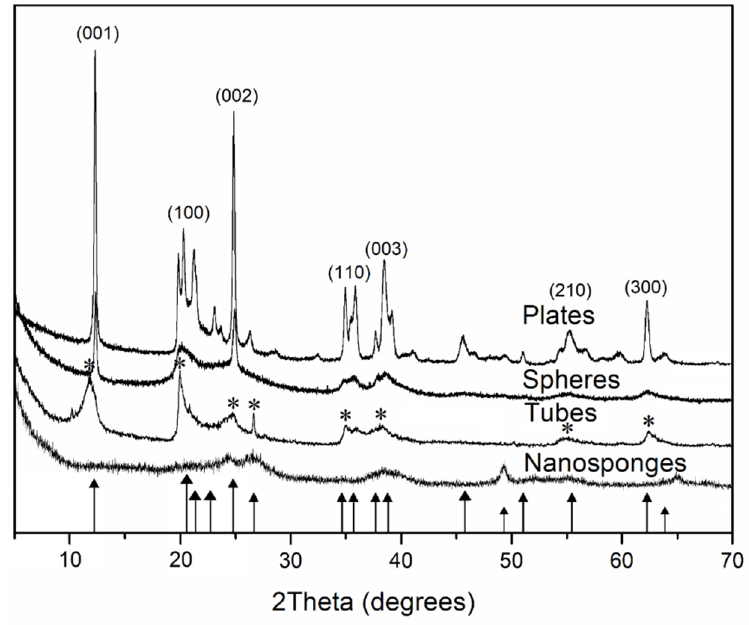
Figure 1. X-ray diffraction patterns of the synthetic aluminosilicate with different morphologies and raw halloysite. Bar chart of the standards: ▲ —kaolinite mineral (PDF No. 79 ‐ 1593); *—raw halloysite (PDF No 00–009-0453).